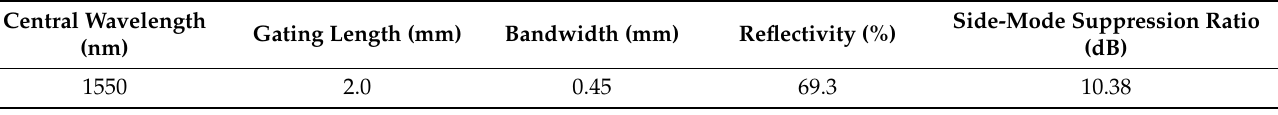
Table 3. The characteristics of the